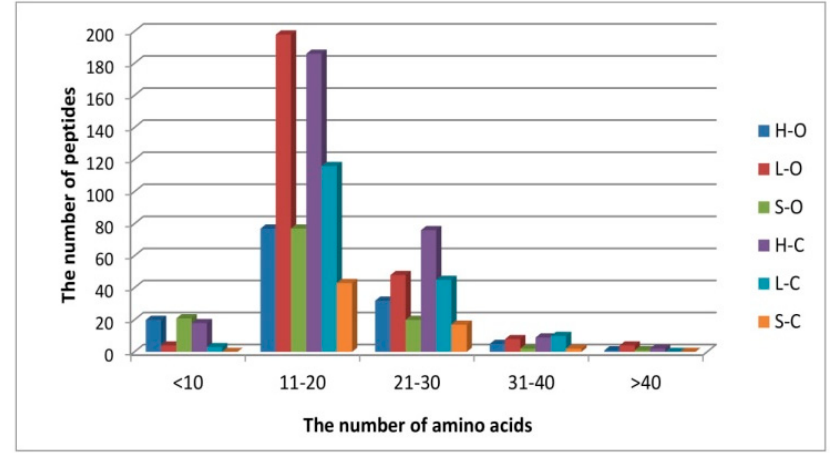
Figure 5. The distributions of peptides based on their number of amino-acid residues (abbreviations: H-O: organic ham, L-O: organic loin, S-O: organic shoulder, H-C: conventional ham, L-C: conventional loin, S-C: conventional shoulder).